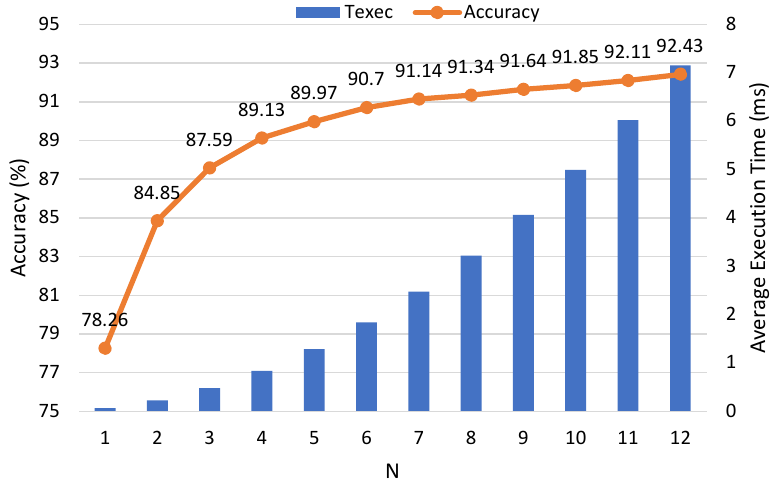
Figure 8. Average execution time of the inference of the proposed model for a variable number of filters with the CIFAR-10 dataset on a ZYNQ7010.